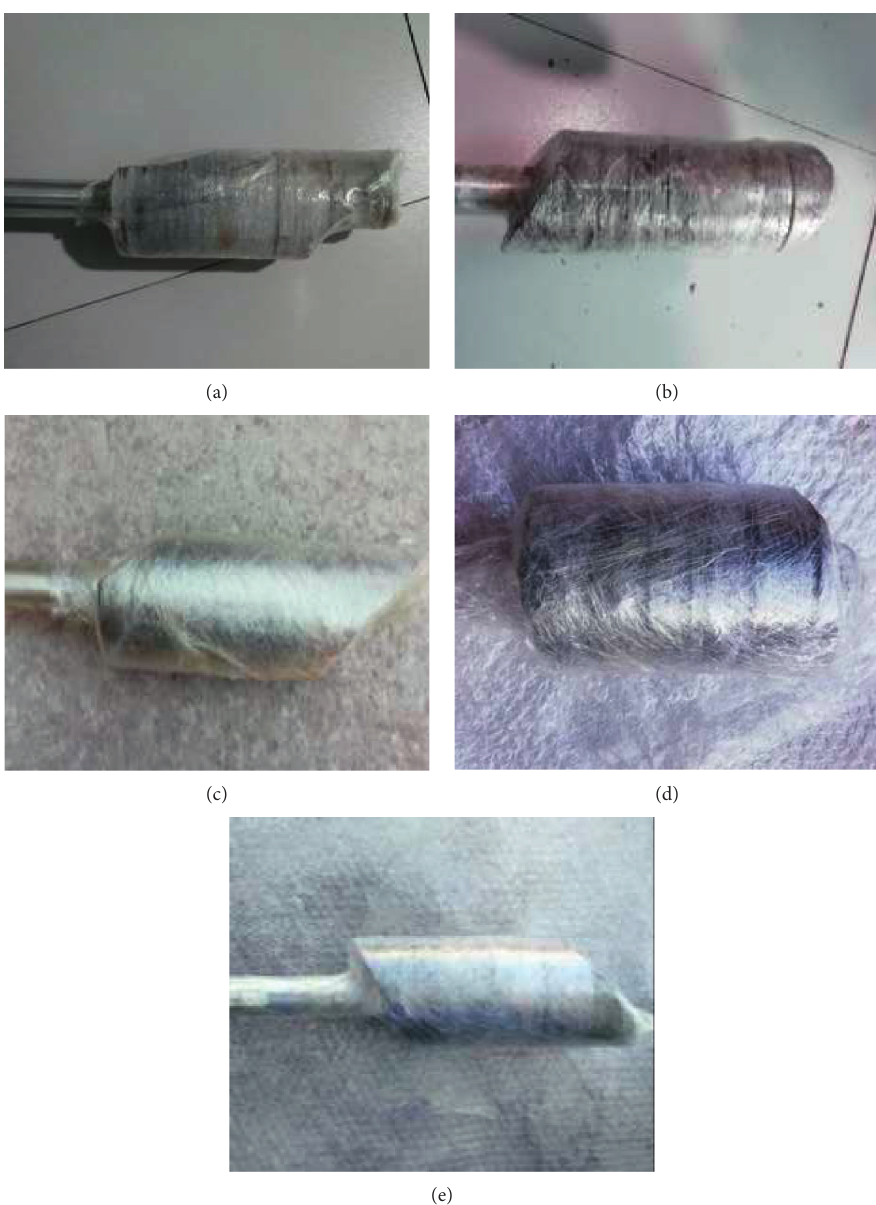
Figure 5: Core with hollow inclusion after release. (a) Measuring point 1. (b) Measuring point 2. (c) Measuring point 3. (d) Measuring point 4. (e) Measuring point 5.